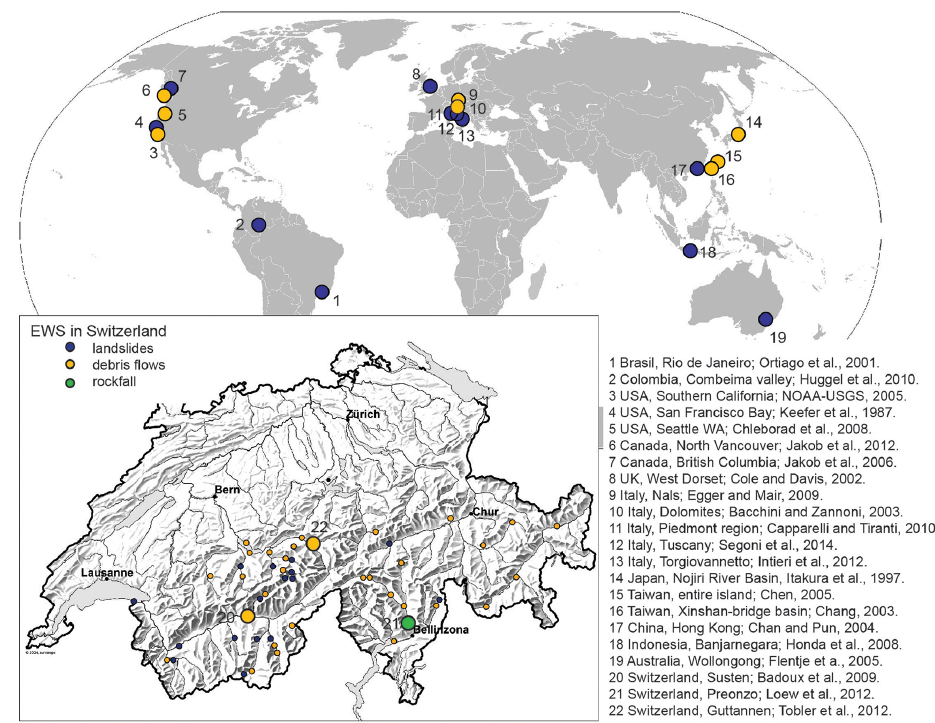
Figure 1. Map of selected EWS sites – worldwide and in Switzerland – reported in